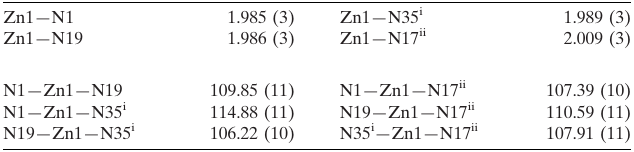
Selected geometric parameters (A˚ , (cid:3) ).